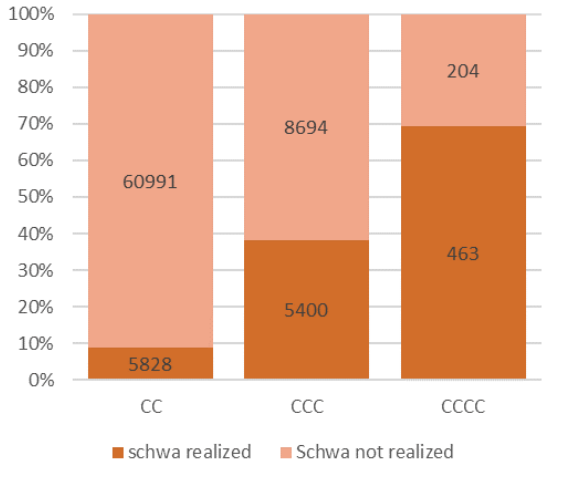
Figure 3. Realization of word-final schwa as a function of consonantal sequence in all three